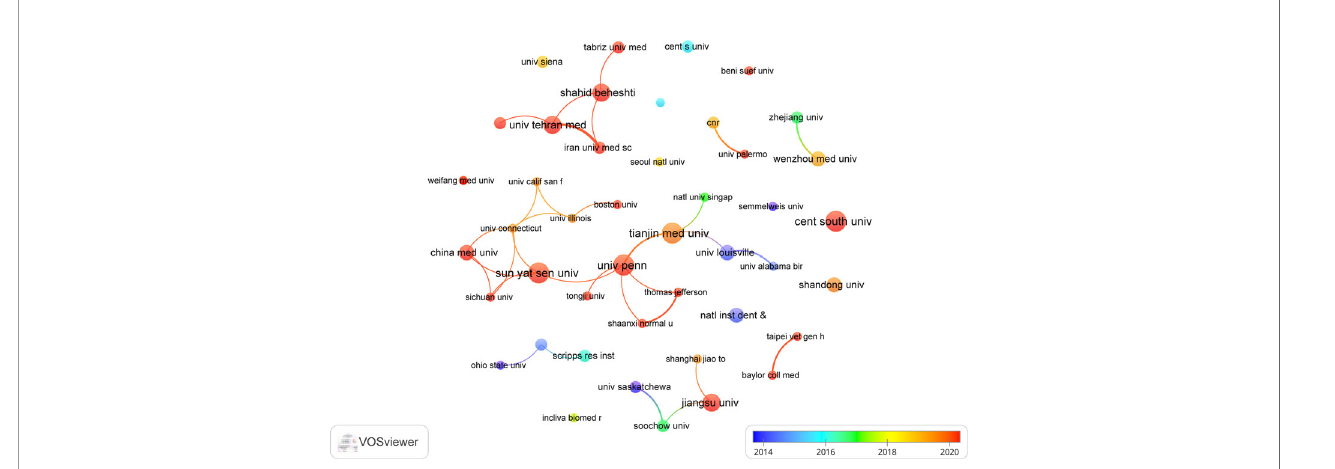
FIGURE 4 | The visualization of institutions on research of exosomes in AIDs.